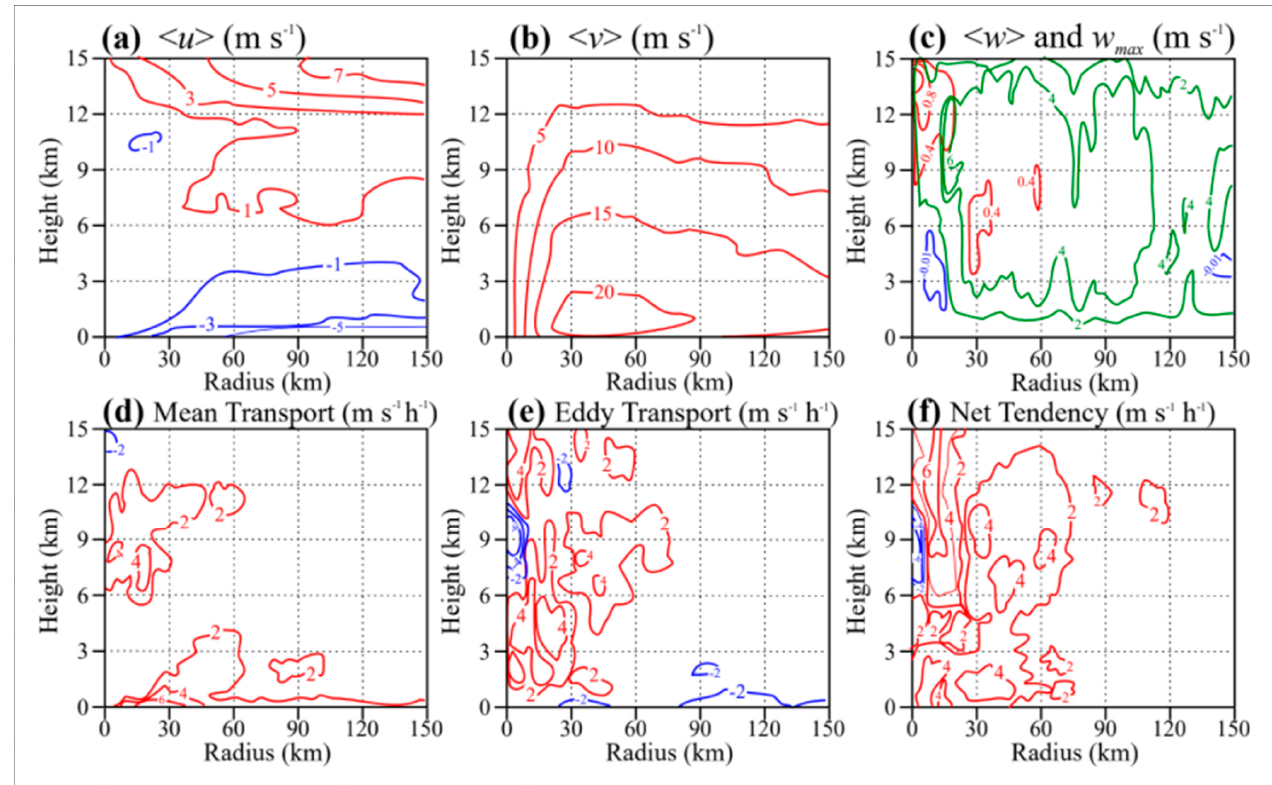
Figure 14. As in Figure 12, except that it shows a 37 h HWRF forecast of Hurricane Michael. The x -axis shows the radius from 0–150 km.